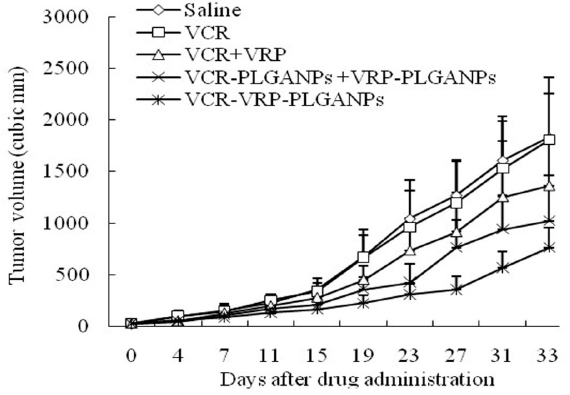
Figure 2. In vivo antitumor effects of various treatment groups against MCF-7/ADR tumor xenograft in BALB/c nude mice ( n = 6). The mice were treated via tail vein injections with saline control, free VCR, free VCR/VRP combination, single-drug nanoparticle combinations and co-encapsulated nanoparticles every three days. The doses of vincristine and quercetin given were 0.05 and 1.25 mg/kg, respectively (1:500 VCR/VRP molar ratio).